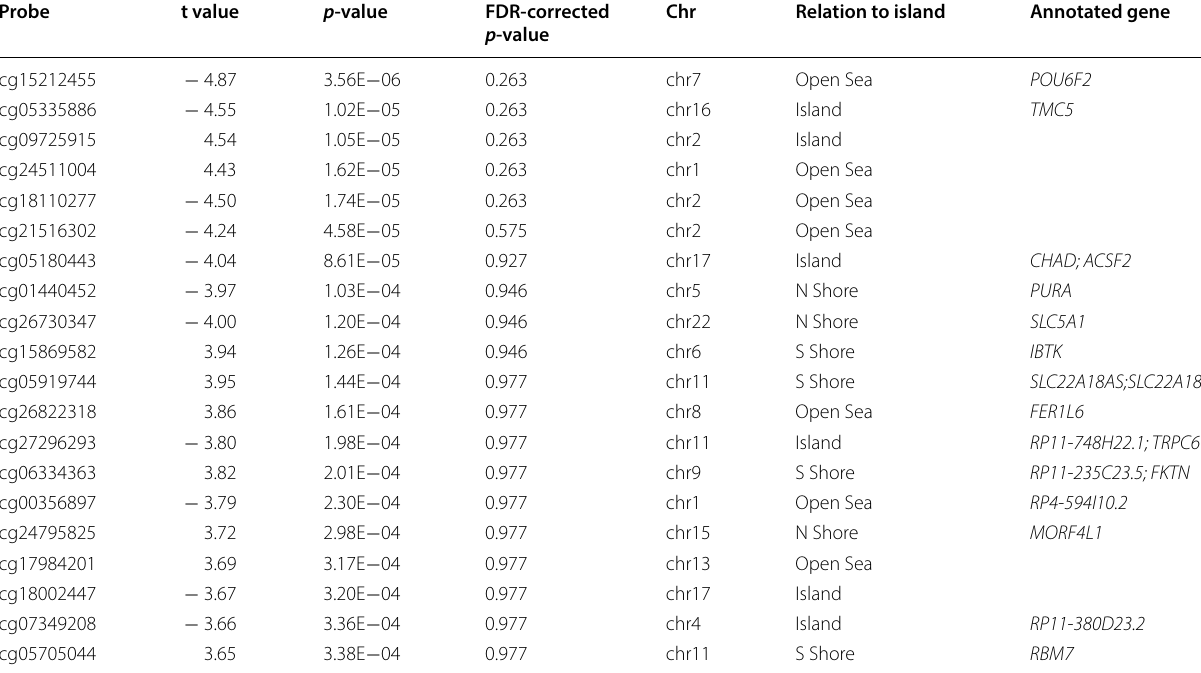
Table 2 Top 20 CpG sites associated with total LEQ scores Probe